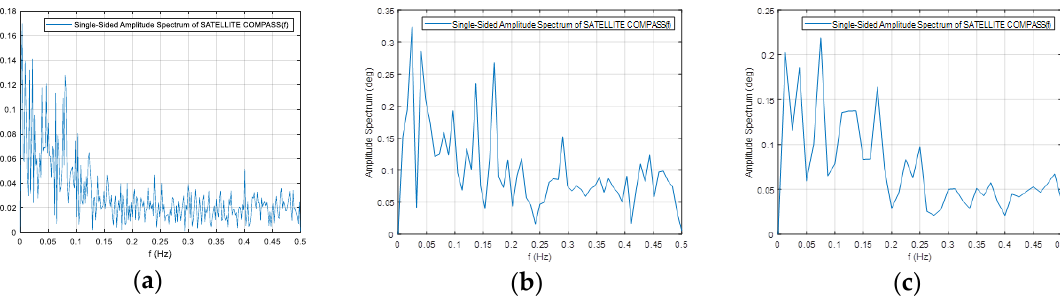
Figure 15. Frequency spectrum for the Novatel compass raw heading records in Figure 12 for the speeds of 10 km/h ( a ), 20 km/h ( b ) and 30 km/h ( c ).